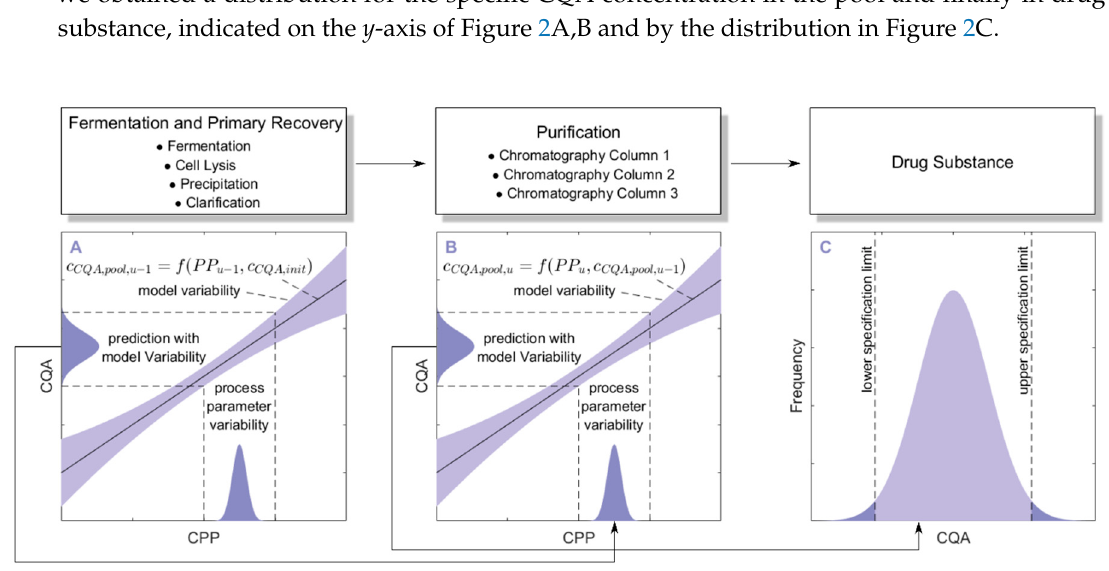
Figure 2. Schematic description of the integrated process model using a Monte Carlo approach: 1000 simulations are performed, each having a different set of process parameters (indicated as distribution on the x -axis of ( A , B )) and initial specific CQA concentration ( c CQA,init ) . Multiple linear regression models describe the relationship between the c CQA of the pool of unit operation u ( B ) and the PP of this unit operation as well as the pool concentration of the previous unit operation u − 1 ( A ). Thereby, models from multiple unit operations ( A , B ) are connected to predict the CQA distribution in the drug substance ( C ). Since 1000 simulations are performed, the CQA values form a distribution after each unit operation. The higher the model uncertainty, indicated by blue shaded area around the regression line, the wider the resulting CQA distribution. This ultimately propagates until drug substance, where the chance of out of specification events can be assessed.